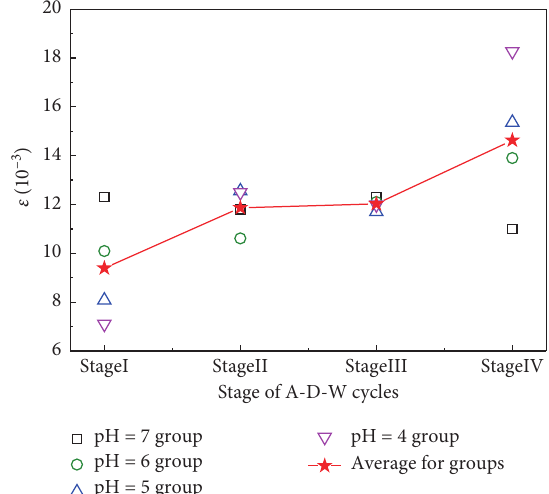
Figure 11: Variation of peak strain of sandstone versus A-D-W